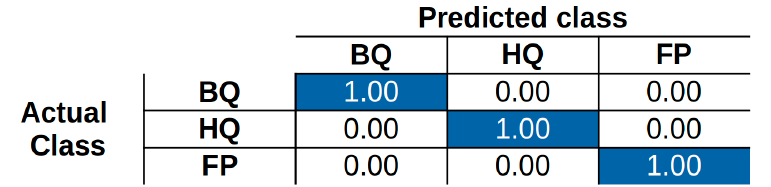
Figure 12. A global overview of the entire workflow of the proposed system. The entire process on a standard machine such as a laptop with Core i7 of 11th gen- eration takes less than 1 s for the entire classification process, as reported in Figure 12. This time is adequate for an online detection of these substances. 5. Conclusions